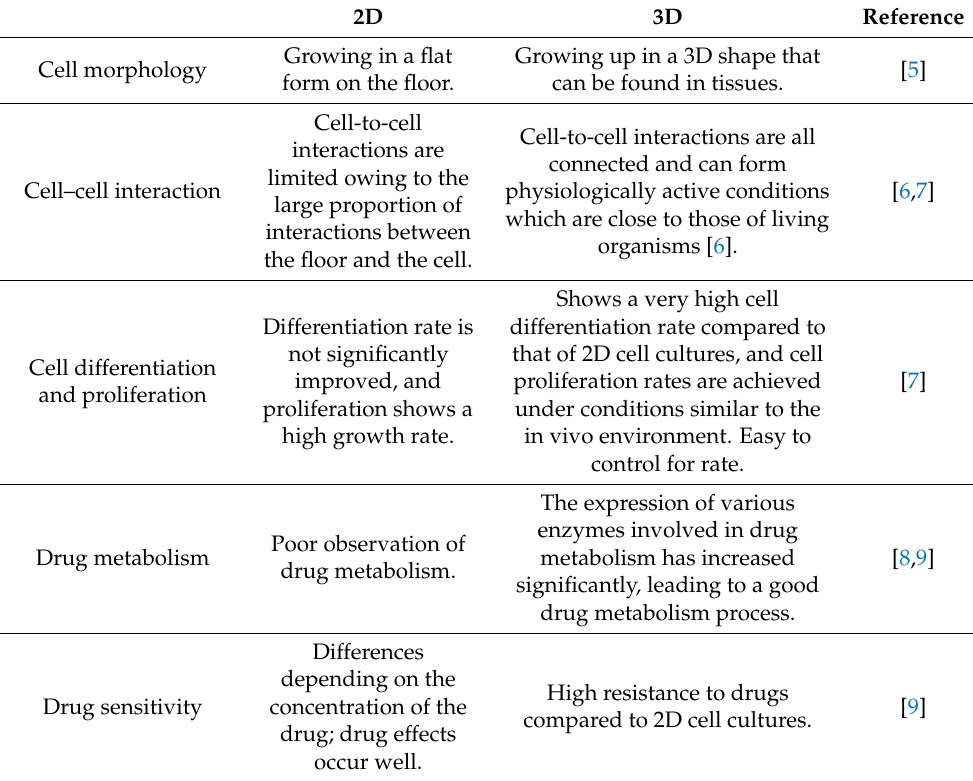
Table 1. Characteristic differences between two- and three-dimensional (2D and 3D) cell cultures. 2D